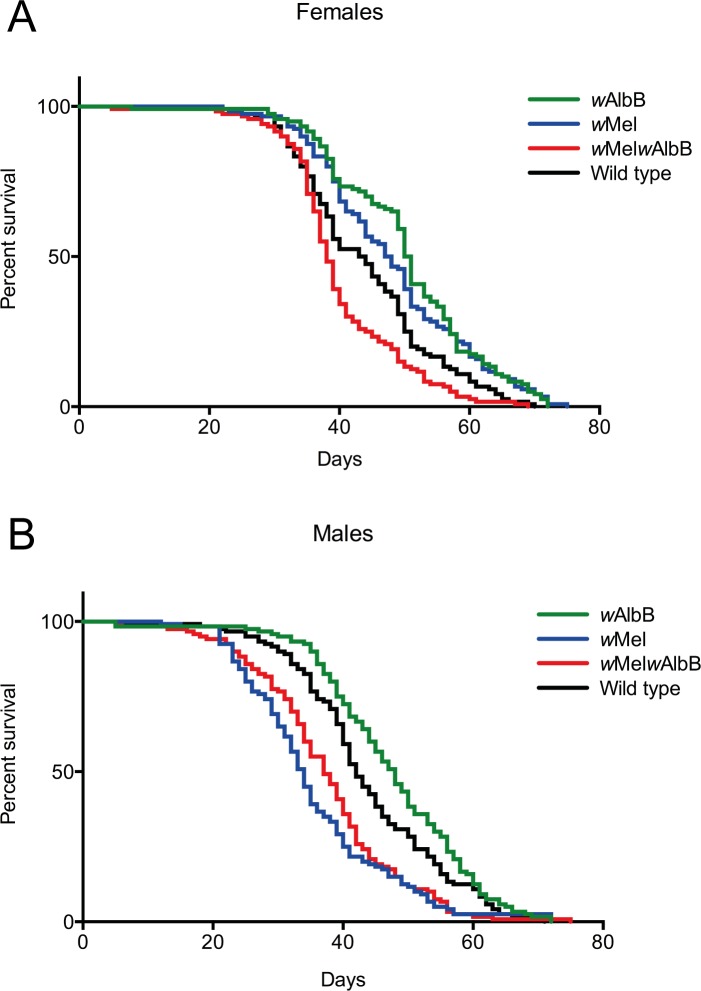
Survival plots comparing the adult lifespan of wild type Ae. aegypti wMel, wAlbB and wMelwAlbB females (A) and males (B).Wild type mosquitoes are indicated in black, wMel in blue, wAlbB in green and wMelwAlbB in red. All experiments were conducted using mosquitoes from G8 of the superinfected line.